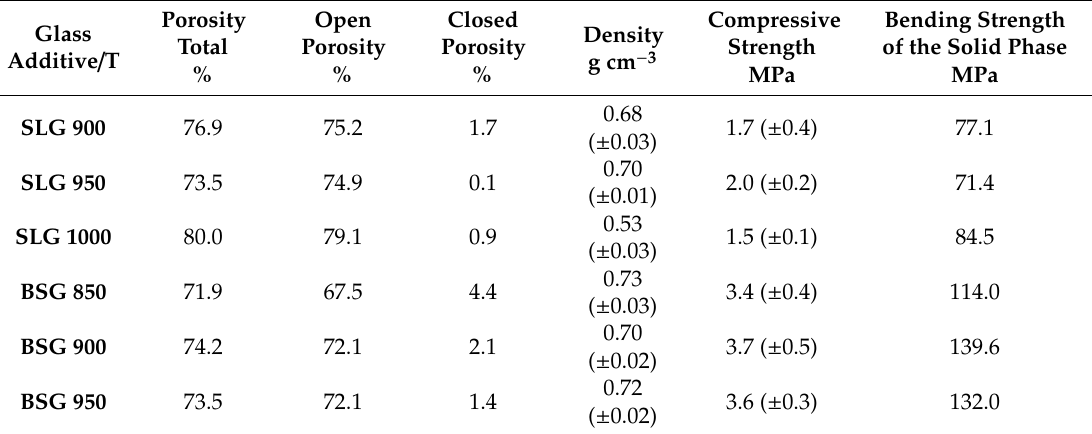
Table 2. Values of porosity, as well as compressive and bending